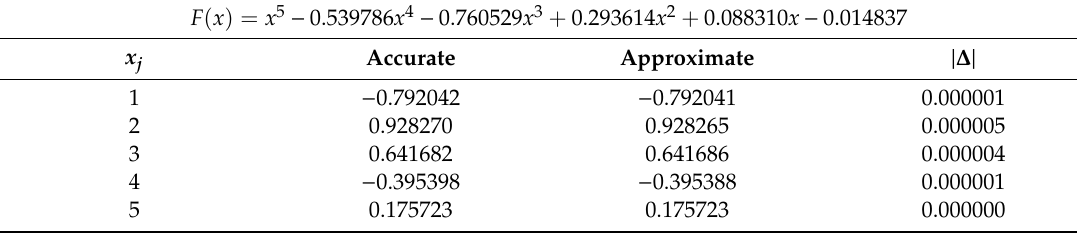
Table 6. Accurate and approximate values determined by the proposed method ( α = 0.00001 )